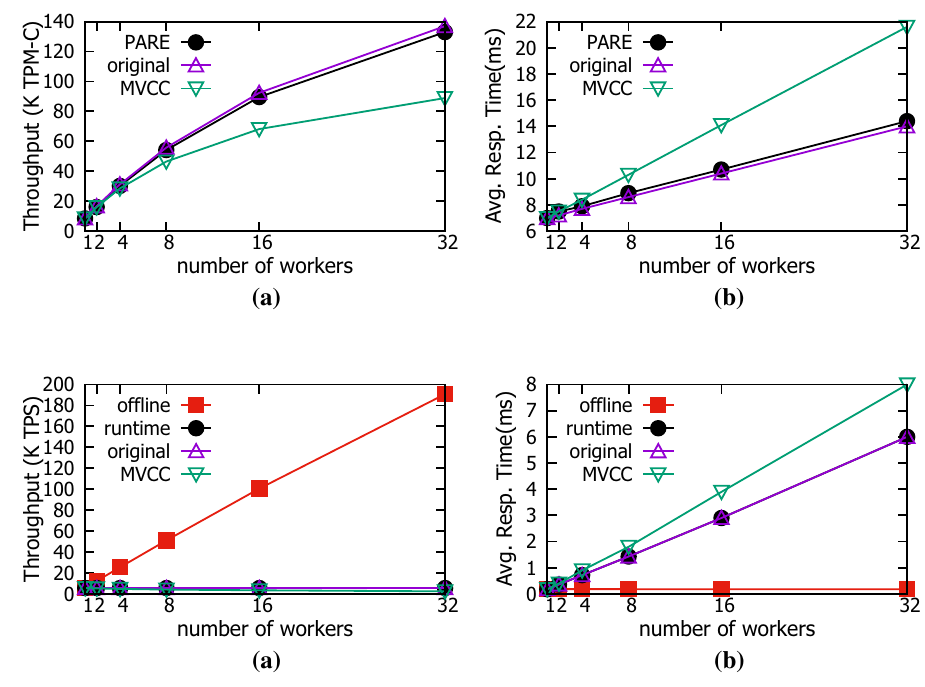
Fig. 6 Performance comparison under TPC-C. a Throughput, b